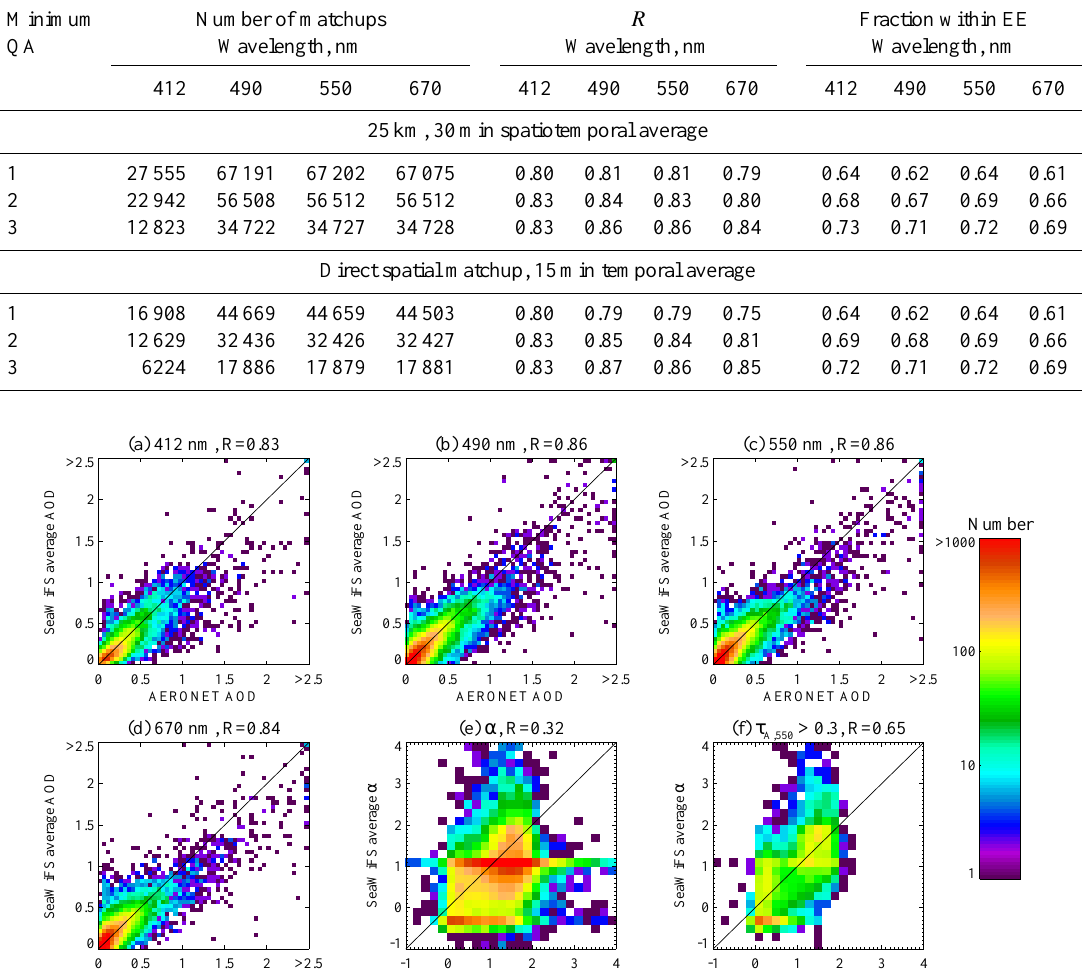
Table 1. Statistics of validation of spectral AOD with AERONET data, for different thresholds on the minimum SeaWiFS QA value permitted, and both area-averaged and direct colocations. R is Pearson’s linear correlation coefficient.